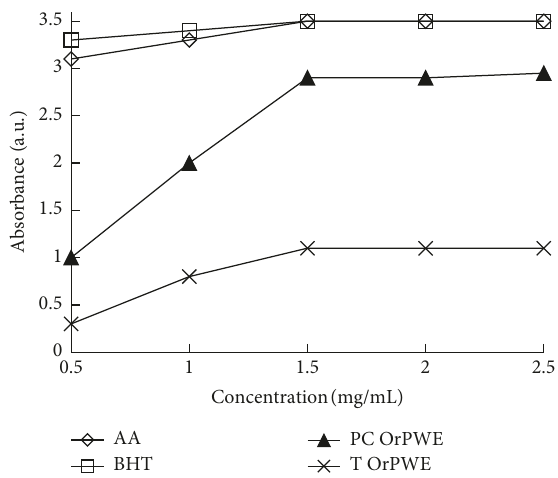
Figure 8: Reducing power of OrPWE in comparison with ascorbic acid and BHT.